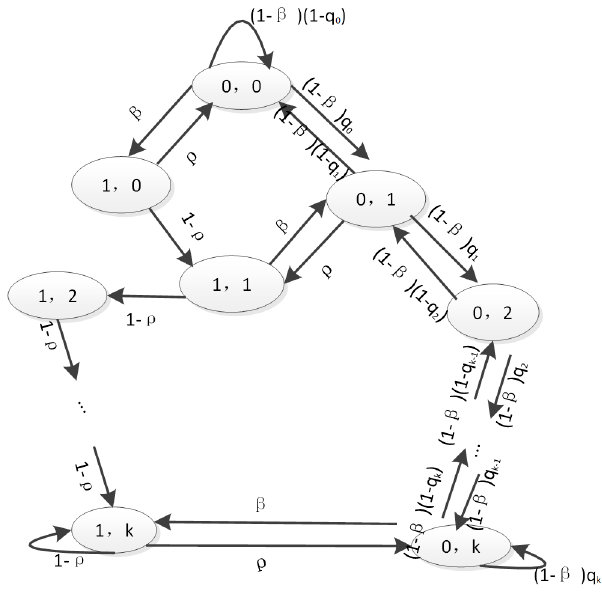
Figure 4. The state transition equation.